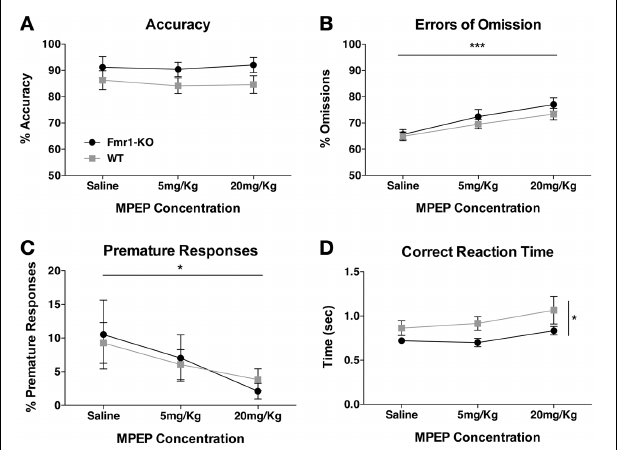
FIGURE 6 | Effect of MPEP on 5CSRTT performance. Accuracy in the 5CSRTT testing phase was unaffected by either low (5mg/Kg) or high (20mg/Kg) MPEP dosage (A) . Errors of omission were significantly enhanced with increasing concentrations of MPEP (B). Premature responses decreased significantly for both groups with increasing MPEP concentrations (C) . Reaction time to the correct aperture did not significantly change with MPEP for either group, although Fmr1 -KO mice reacted faster to the correct aperture (D) . Values plotted represent means ± SEM. Analysis was performed with a 2-way repeated measures ANOVA with Bonferroni’s post-test analysis. Asterisks indicate significance levels; ∗∗∗ p < 0 . 001, ∗ p < 0 .